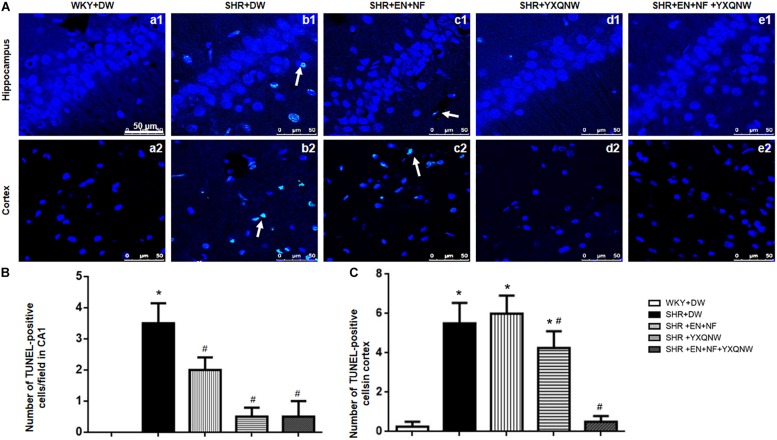
YXQNW inhibits CA1 neuron death in hippocampus and cortex. (A) Representative images of neuron death in hippocampus CA1 and cortex of WKY + DW group (a1,a2), SHR + DW group (b1,b2), EN + NF group (c1,c2), YXQNW group (d1,d2), and EN + NF + YXQNW group (e1,e2). White arrows indicate the localization of TUNEL-positive cells. Bar = 50 μm. (B) Statistic analysis of neuron death, the data were derived from five randomly selected micrographs in hippocampus for each animal. (C) Statistic analysis of neuron death evaluated in five randomly selected micrographs in cortex for each animal. The area of each micrograph selected was 2.1 × 104 μm2. Values are the mean ± SEM. ∗P < 0.05 vs. control group, #P < 0.05 vs. SHR + DW group. n = 20.